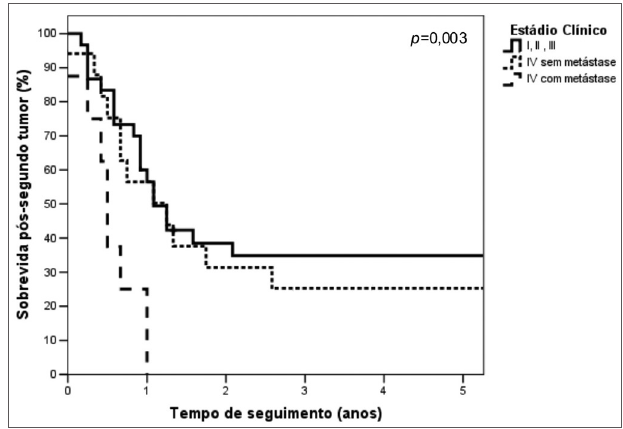
Figura 3. Curvas de sobrevida pós-segundo tumor primário de acordo com o estádio clínico do segundo tumor. A sobrevida foi diferente de acordo com a locali- zação do STP (Figura 4) (p=0,005). Apenas os